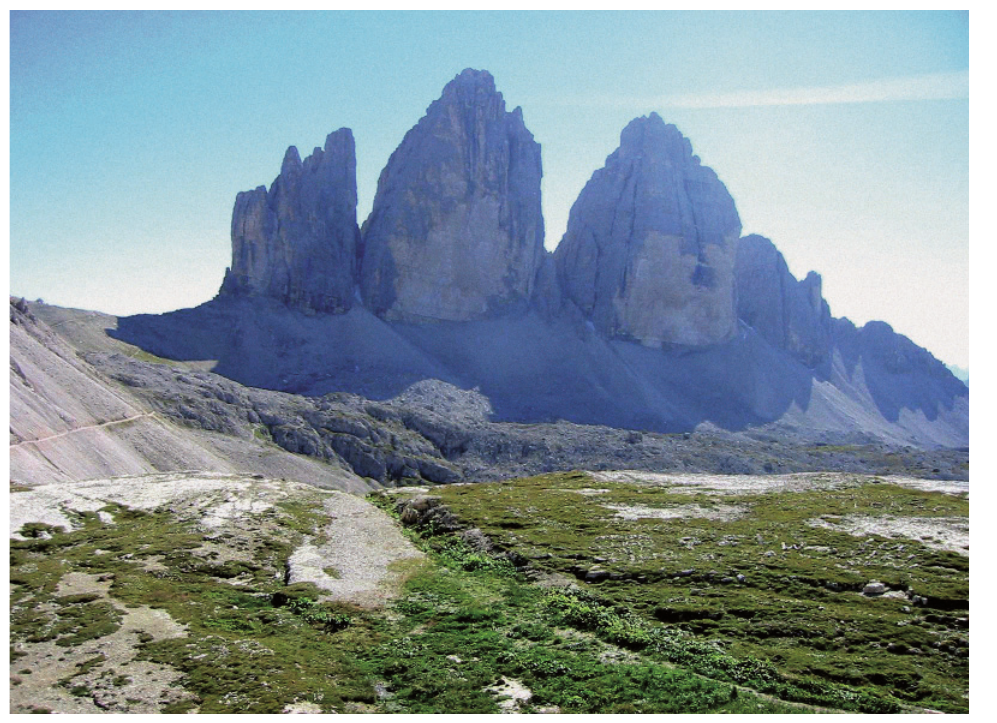
Figure 2. The Dolomites (from